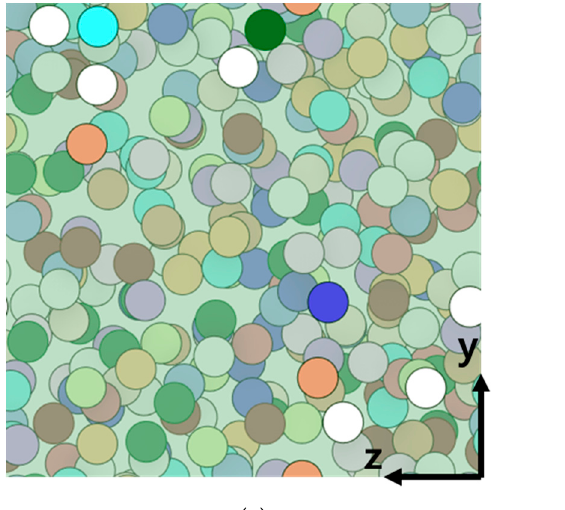
Figure 4. Y-Z section of the finite element analysis model. ( a ) Aspect ratio 0.4, ( b ) Aspect ratio 15.